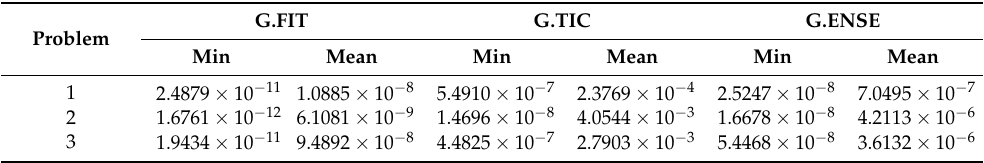
Table 3. Global statistics for the solution of Problems 1–3 based on the second kind of NLE-PDSM using